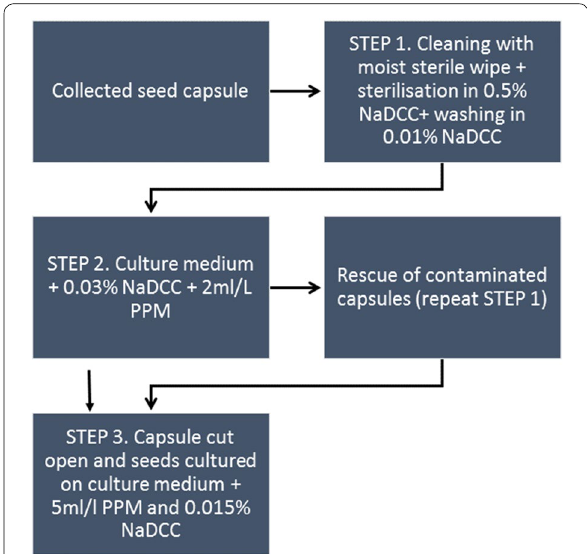
Fig. 8 Flow chart explaining the different steps of sterilisation and culture in vitro of different types of wild collected orchid seed capsules, and final culture under laboratory conditions. Sodium dichloroisocyanurate (NaDCC) was used as sterilant and antimicrobial at different concentrations in culture while plant preservative mixture (PPM) was used at different concentrations as an antimicrobial